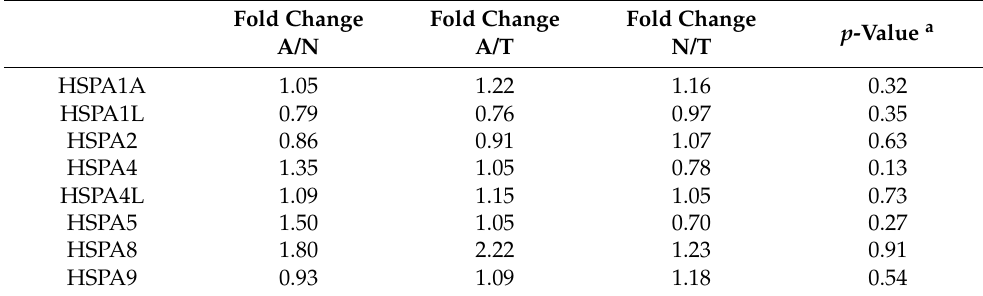
Table 4. Comparison of the abundance of HSP70 isoforms between astheno-teratozoospermic, normozoospermic and teratozoospermic